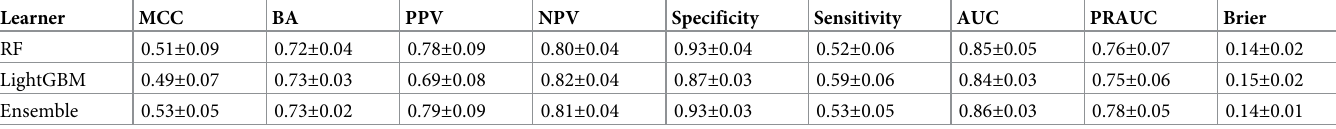
AUC: area under the receiver operating characteristics curve, PRAUC: area under the precision-recall curve, balanced accuracy BA = ((TP/(TP+FN)+TN/(TN+FP)))/2, negative predictive value (NPV) = TN/(TN+FN), positive predictive value (PPV) = TP/(TP+FP), sensitivity = TP/(TP+FN), specificity = TN/(TN+FP), Matthews p correlation coefficient (MCC) = (TP × TN-FP × FN)/ (TP+FP)(TP+FN)(TN+FP)(TN+FN), Brier = mean squared error between predicted probabilities and the